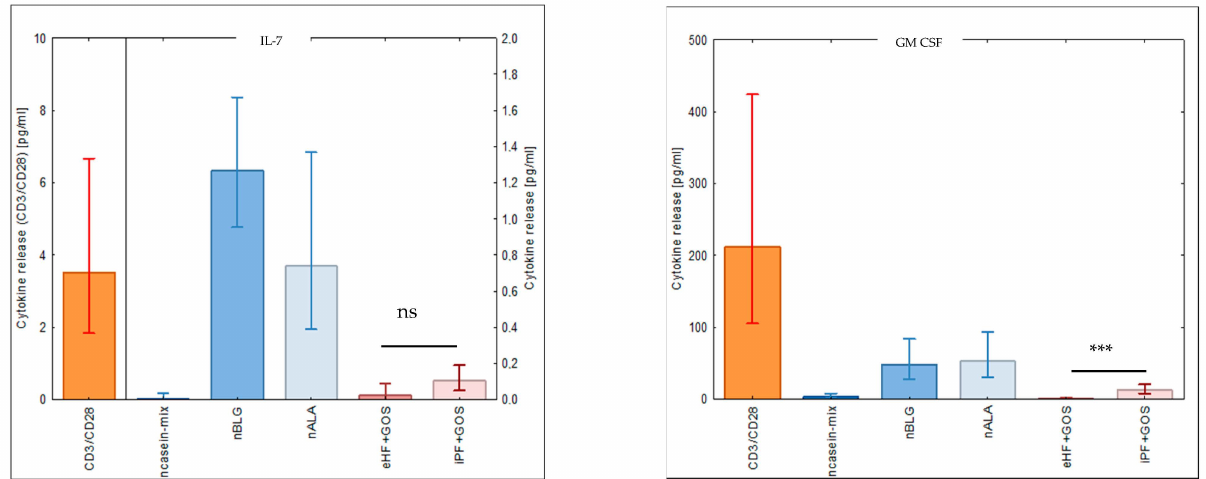
Figure 5. Cytokine responses specific for milk allergens and milk products. Shown are the back- transformed means +/ − SEM of cytokines (as indicated on top of each figure) measured in super- natants of cultured PBMC samples from subjects 48–56 (Table 1) that had been stimulated with anti-CD3 and anti-CD28 (positive control), milk allergens, eHF + GOS and iPF + GOS ( x -axis; Table 2). Only eHF and iPF were compared statistically (ns, not significant, ** p ≤ 0.01, *** p ≤